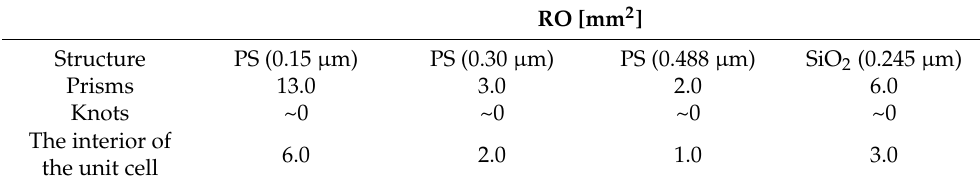
Table 1. Quantification of the order quality of self-assembly of sub-micron spheres .